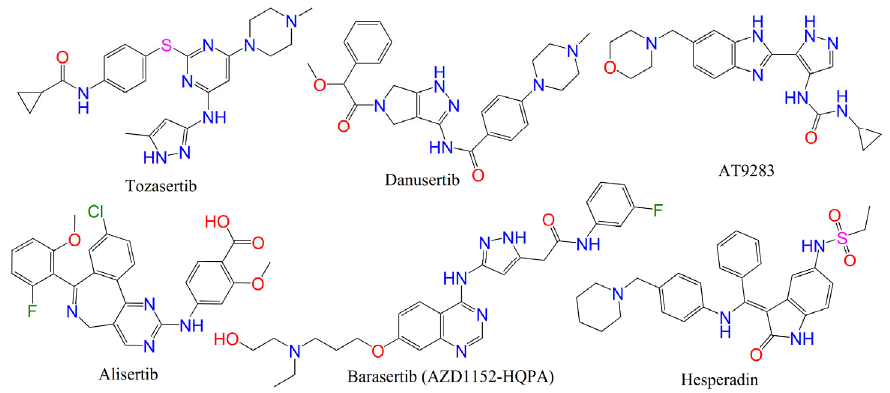
Figure 1. Structures of some known aurora inhibitors in different clinical trial stages.